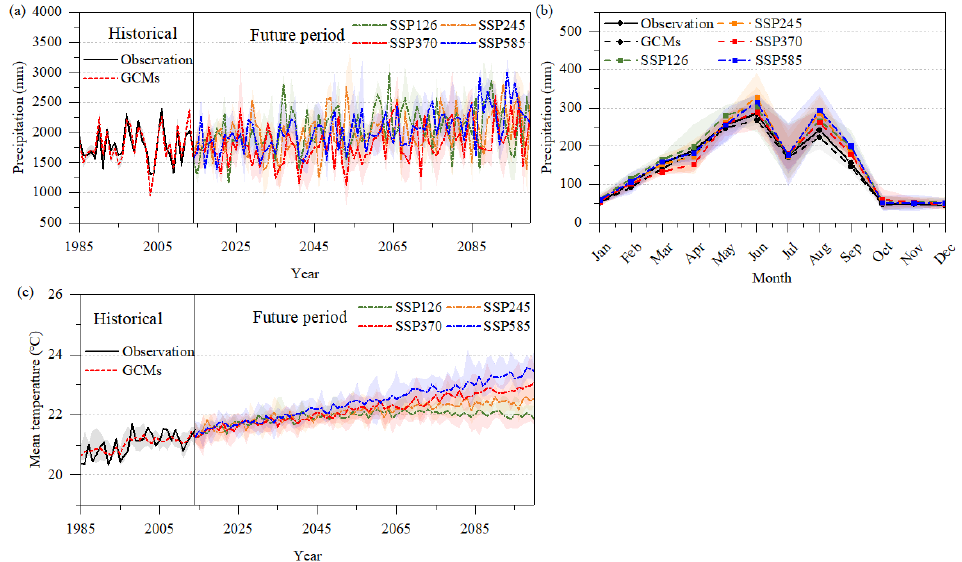
Figure 3. The changes in annual mean precipitation ( a ) and air temperature ( c ) from the ensemble mean of corrected GCMs under the four SSP–RCPs for the period 1985–2100 and the mean monthly precipitation ( b ) for the period 2015–2100, while the observations (solid black line) are calculated for the period